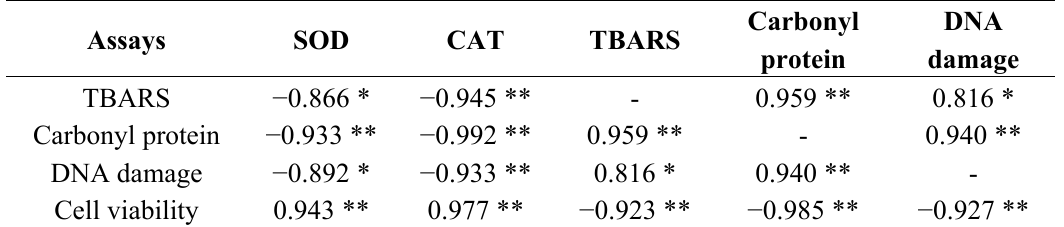
Table 3. Pearson correlations between cellular antioxidant enzymes activities, lipid and protein oxidative damage, DNA damage index, and cell viability